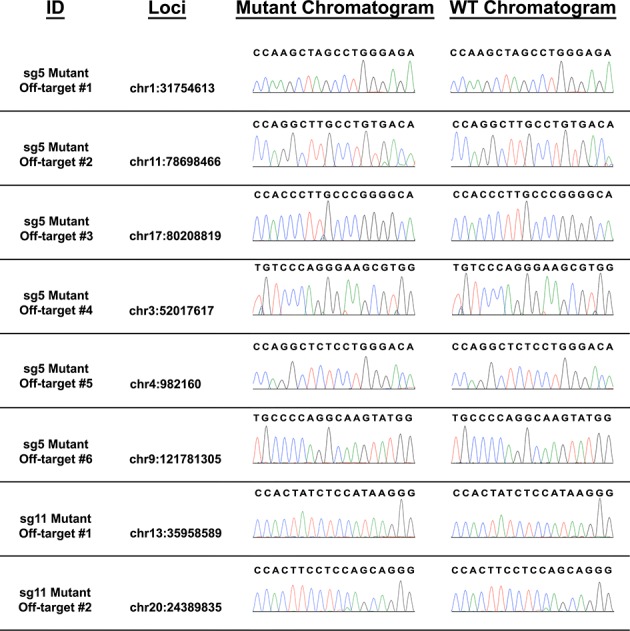
Off-target analysis of sg5 and sg11 OCLN mutant lines.Schematics of potential off-target loci for OCLN sg5 and sg11 mutant lines, obtained at http://chopchop.cbu.uib.no/.